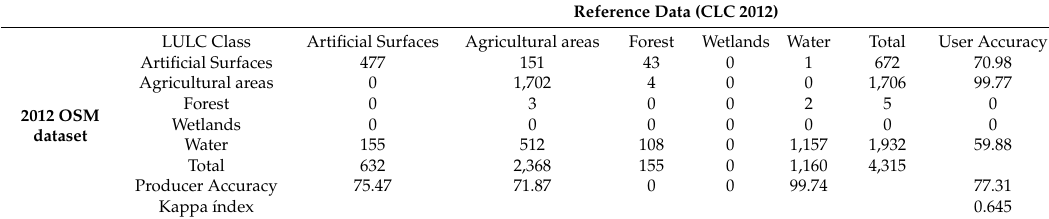
Table 7. Thematic accuracy for 2012 (in ha).